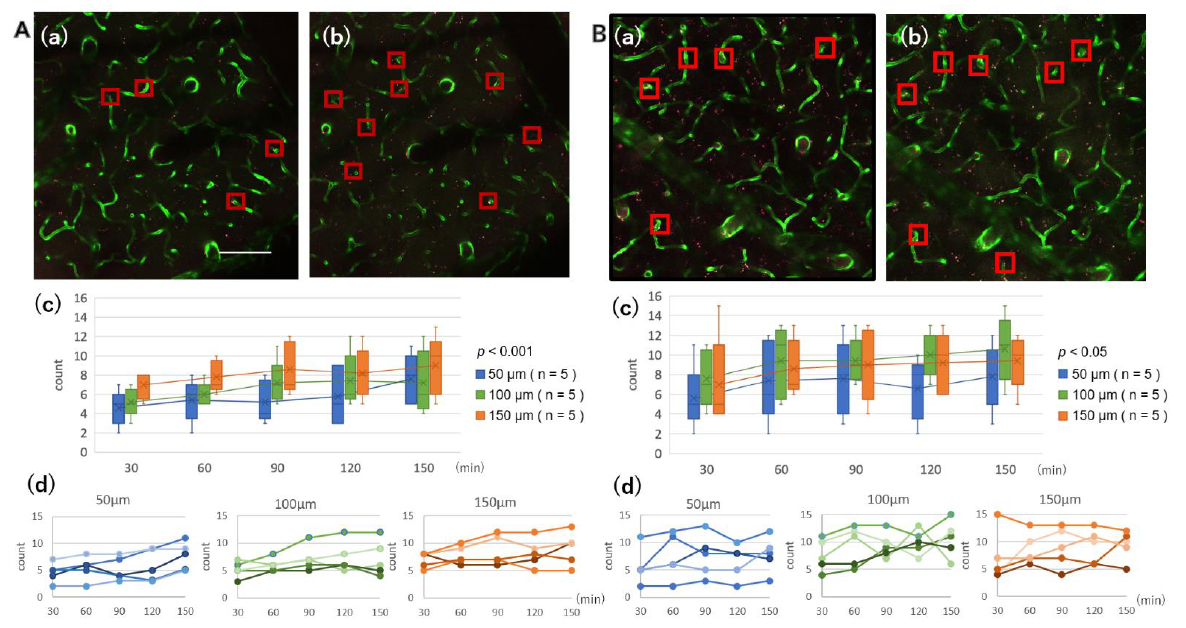
Figure 4. Both A β oligomers ( A ) and fibrils ( B ) accumulated progressively in parenchymal capillaries. The number of capillaries with A β accumulation, indicated with squares in Panels ( a , b ), in a 509 µ m square was counted at depths of 50, 100, and 150 µ m every 30 min from 30 min ( a ) to 150 min ( b ). In contrast with the planar distribution of A β in the penetrating vessels, A β accumulated in a spot along the capillaries. Progressive accumulation was significant both in the oligomers ( p < 0.001) and in the fibrils ( p < 0.05) ( A ( c , d ), B ( c , d )). ( A ( c ), B ( c )) are box-and-whisker plots of data shown in ( A ( d ), B ( d )), respectively. The speed of accumulation was faster in oligomers than in fibrils. The A β accumulation measured at 3 depths was not statistically different between them. Scale bar: ( A ) 100 µ m.